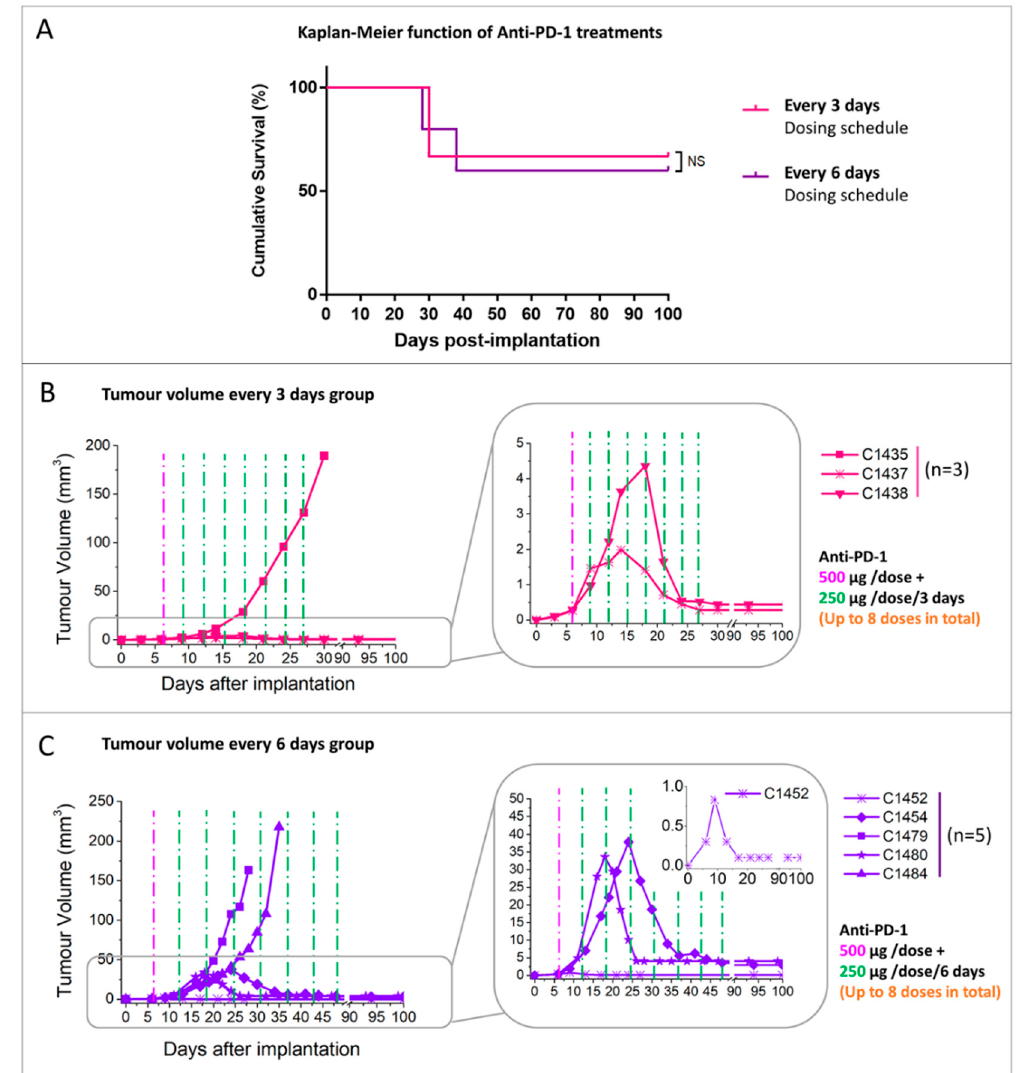
Figure 4. Mice bearing similar sized tumours on the therapy starting day and treated with different anti-PD-1 dosing schedules. ( A ) survival Kaplan–Meier curves for mice treated with anti-PD-1 every 3 days dosing schedule ( n = 3, pink line) and IMS ( n = 5, purple line); ( B ) tumour volume evolution of mice treated with anti-PD-1 every 3 days dosing schedule ( n = 3, pink lines); ( C ) tumour volume evolution of mice treated with anti-PD-1 in IMS ( n = 5, purple lines). The purple and green dashed line (500 μ g/dose and 250 μ g/dose separately) indicate therapy administration time points. Inset at bottom right shows expanded views of 3 of the 5 investigated tumours in C. NS = non-significant difference for the Log-Rank test for the comparison between different groups.